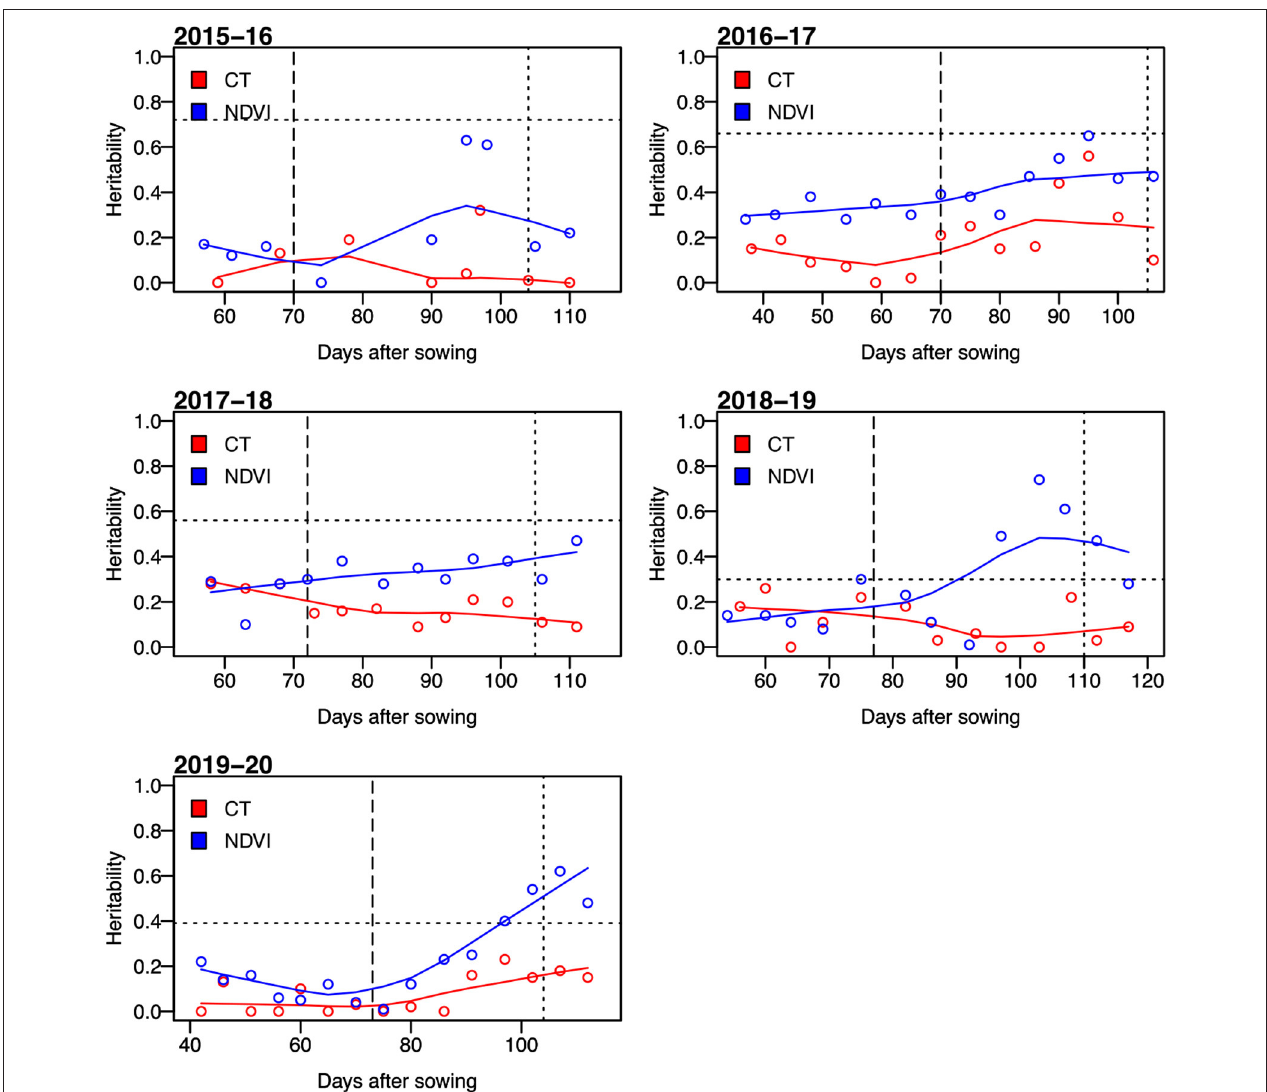
FIGURE 1 | Broad-sense heritability of the normalized difference vegetation index (NDVI) and canopy temperature (CT) for days after sowing in five growing seasons from 2015–16 to 2019–20. The horizontal dotted lines represent the heritability of grain yield. The vertical dashed lines indicate average days to heading, and the dotted lines represent the average days to physiological